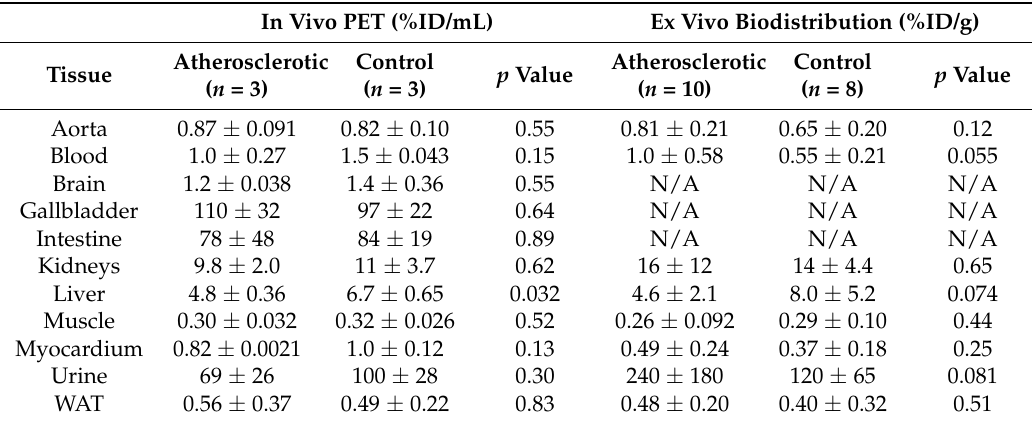
Table 2. Ex vivo biodistribution results calculated separately for male and female mice. Control Tissue (Male, n = 8)